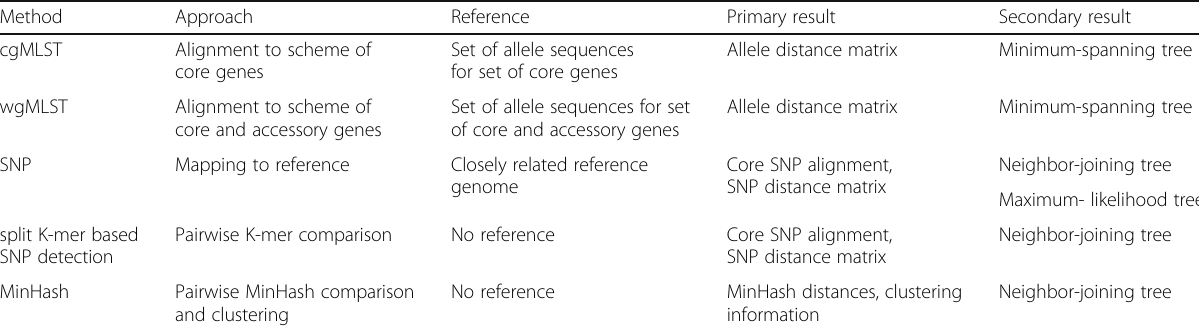
Table 1 Phylogenetic approaches